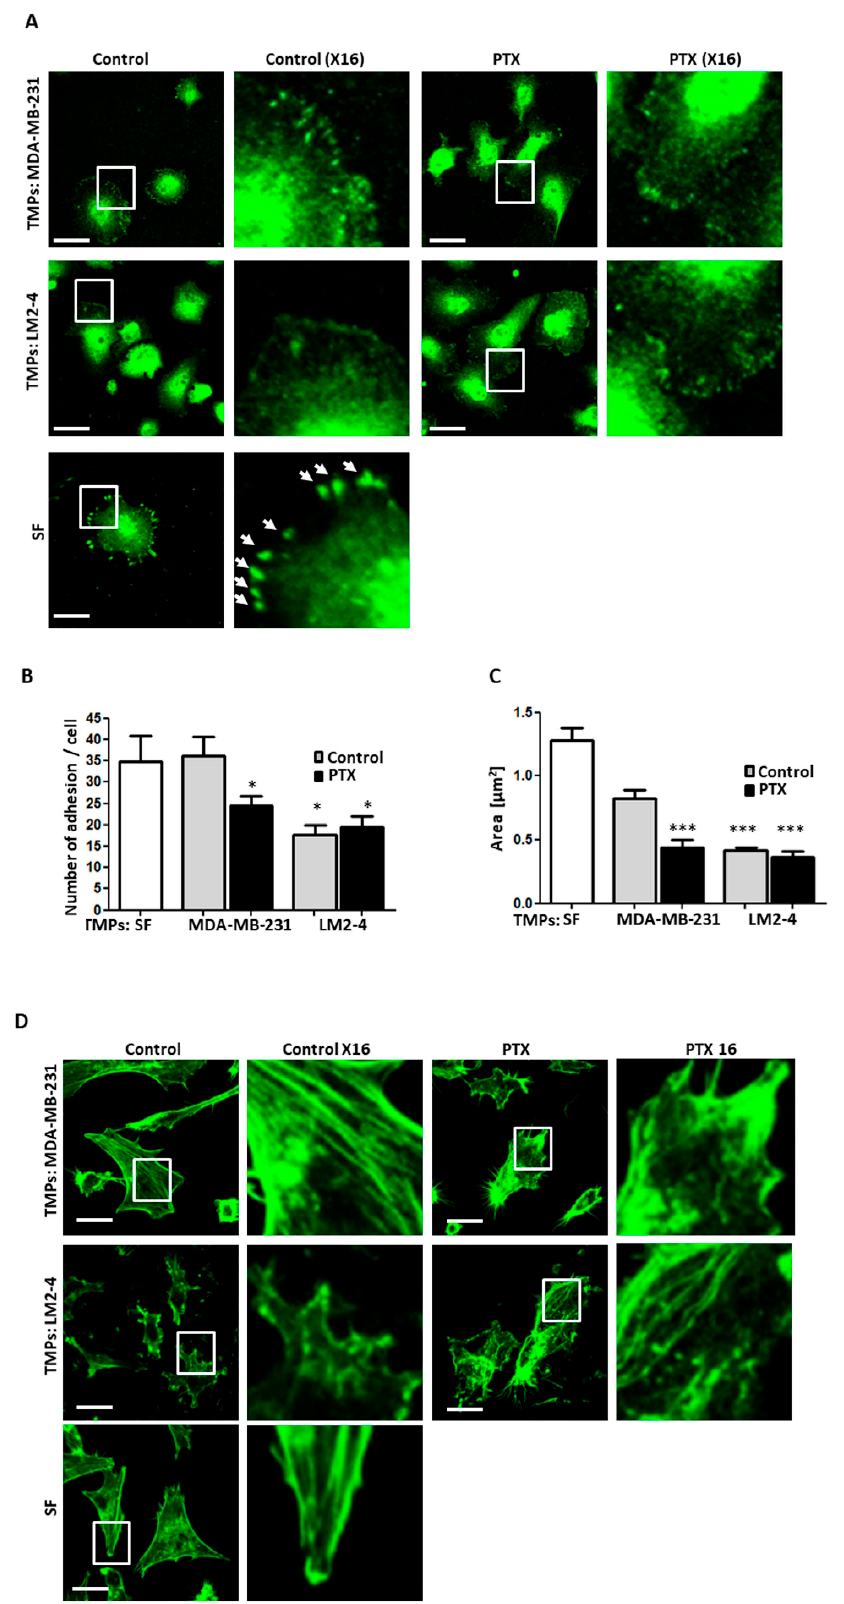
Figure 3. TMPs from highly metastatic cells or cells exposed to chemotherapy decrease focal adhesions and disrupt filament structure. ( A – C ) MDA-MB-231 cells cultured with TMPs from MDA- MB-231 or LM2-4 cells exposed to PTX or vehicle control were seeded on fibronectin-coated plates to assess focal adhesion plaques by vinculin immunostaining (green). MDA-MB-231 cells cultured with